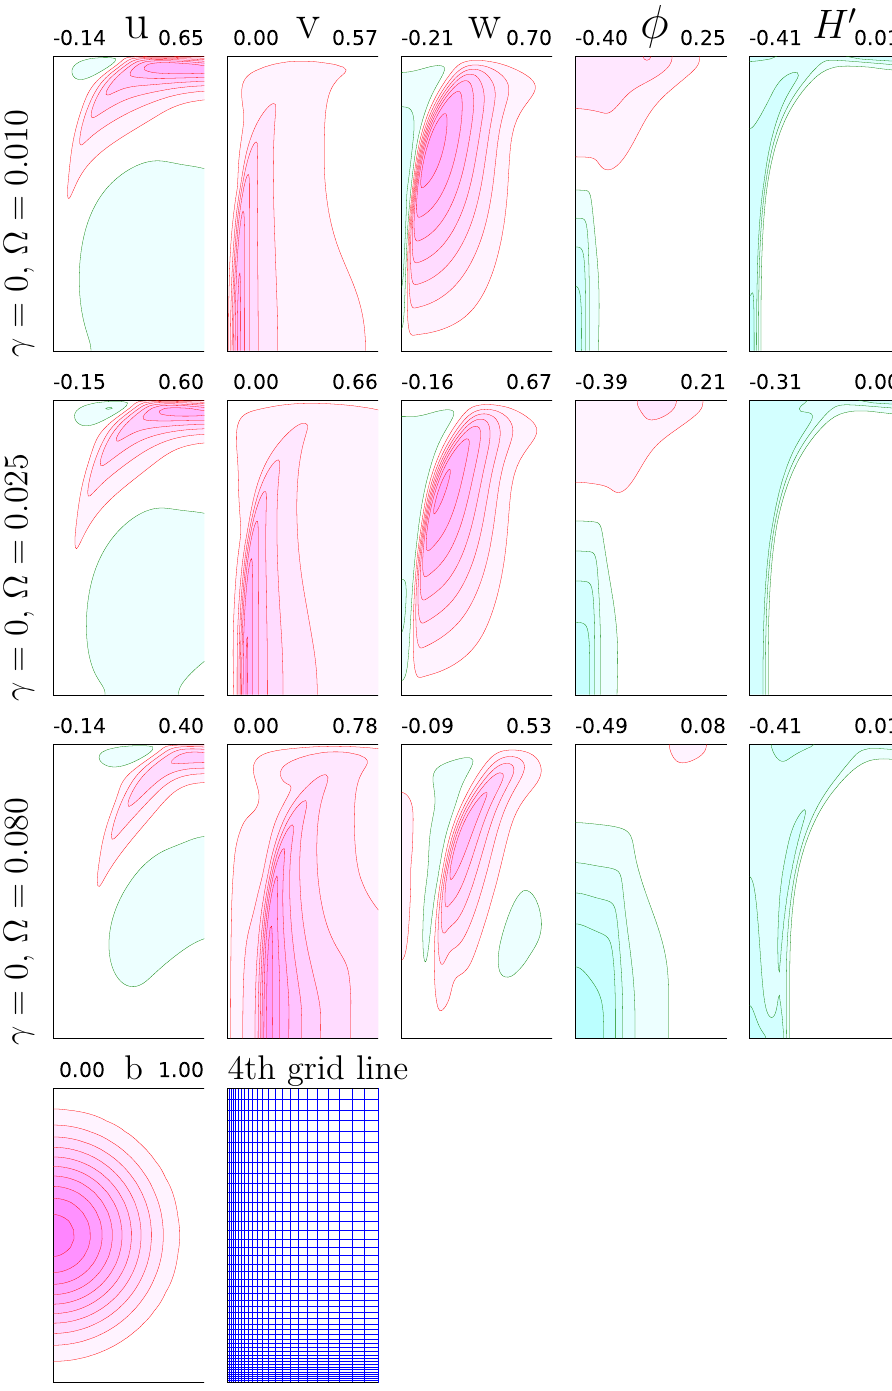
181 grid are the same for all ×